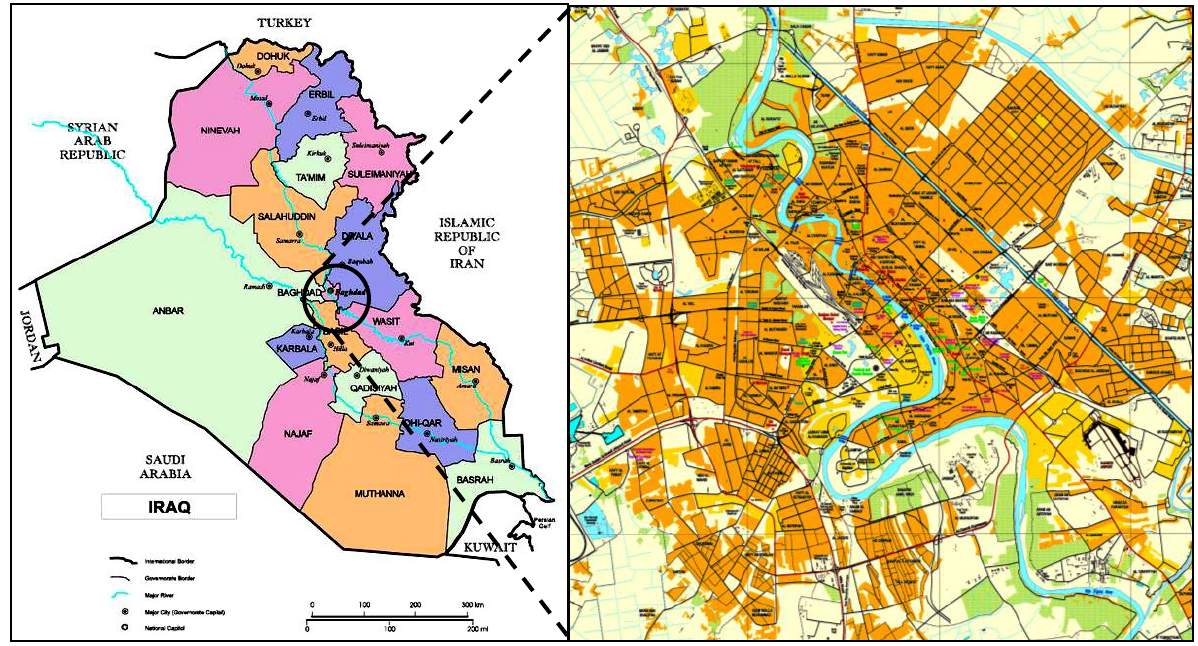
Figure 1. Map of Iraq with focusing on Baghdad City [6, 7]